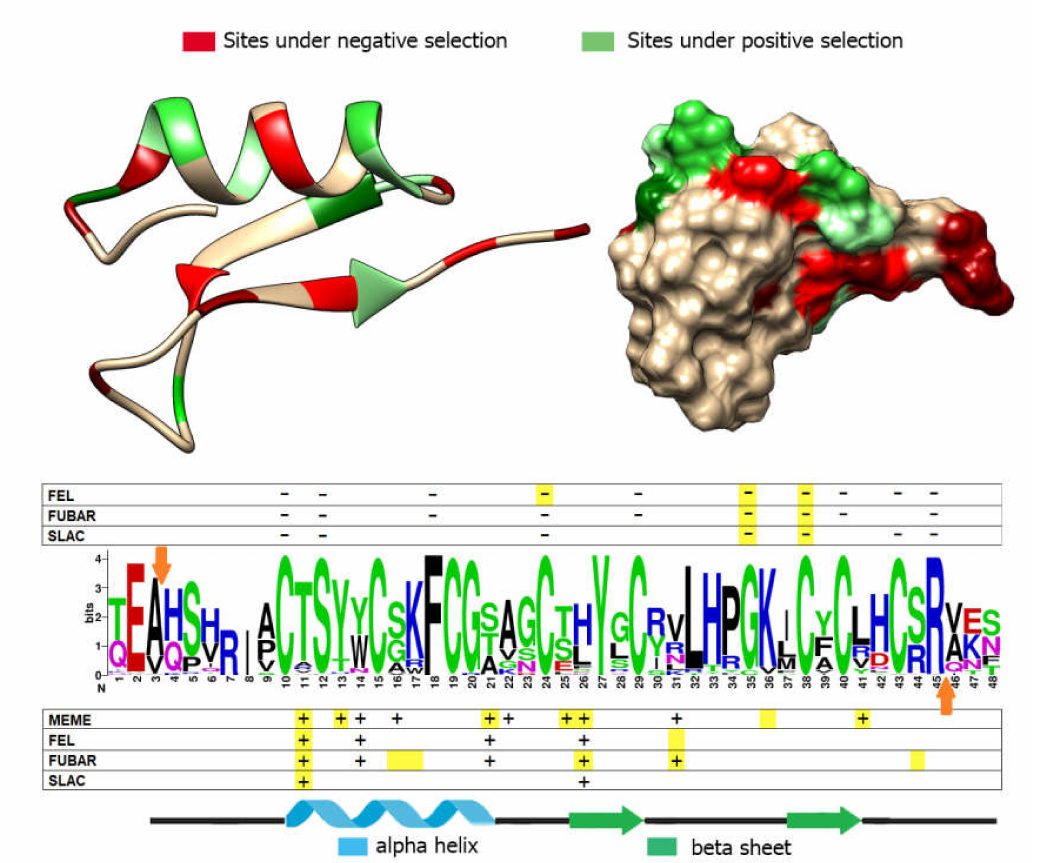
Figure 5. Positive and negative selection analysis. Exon 3 of all conventional myticins were selected to perform the analysis, discarding pseudogenic sequences. Four prediction models have been used (MEME,FEL,FUBAR,andSLAC).Positivelyselectedsites( + )andnegativelyselectionsites( − )identified in the complete myticin sequence dataset are both shown on the graph. Positively and negatively selected sites identified in the myticin C sequence clade are marked with a yellow background. Orange arrows point to the beginning and end sites of the mature peptide. The ribbon structure and the molecular surface, highlighting in red the sites under negative selection and in green the sites under positive selection, are also shown [from